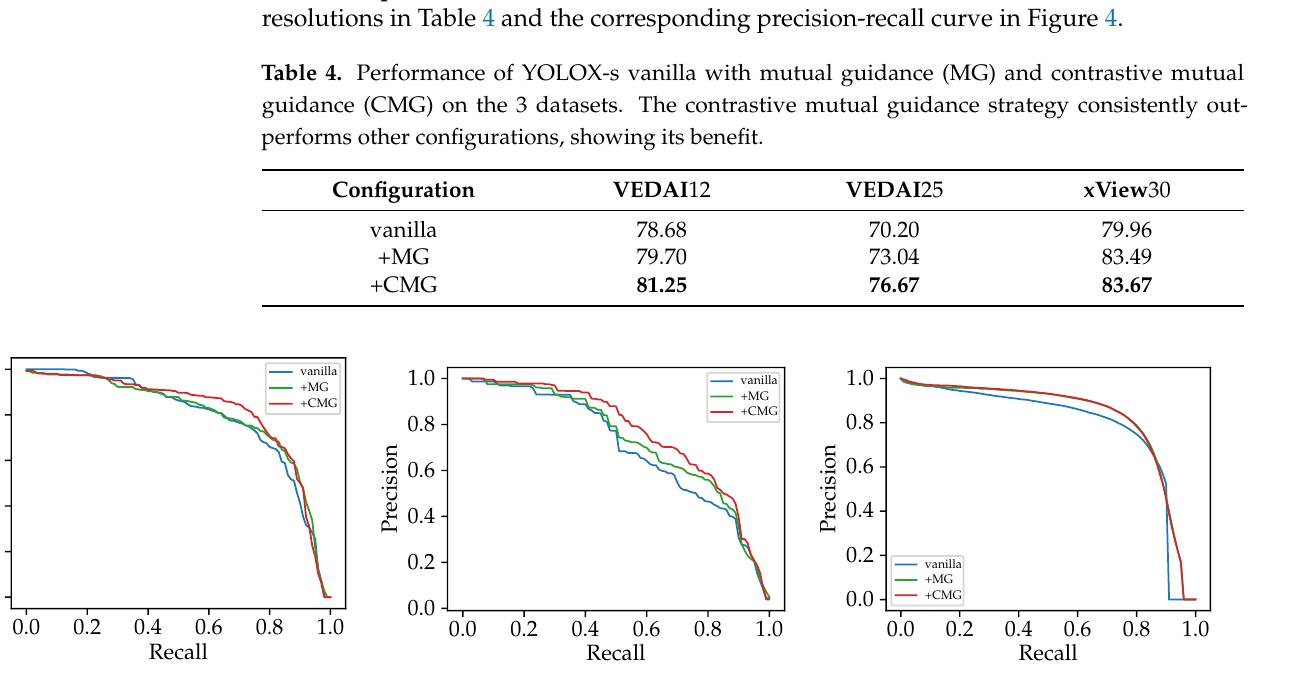
Figure 4. Precision-Recall curve of YOLOX-s on 3 datasets, from left to right: VEDAI12, VEDAI25, and xView30. The methods with +CMG gain improvement over the others at around recall level of 0.5 for the VEDAI datasets and both +MG and +CMG outperform the vanilla method on the xView dataset.